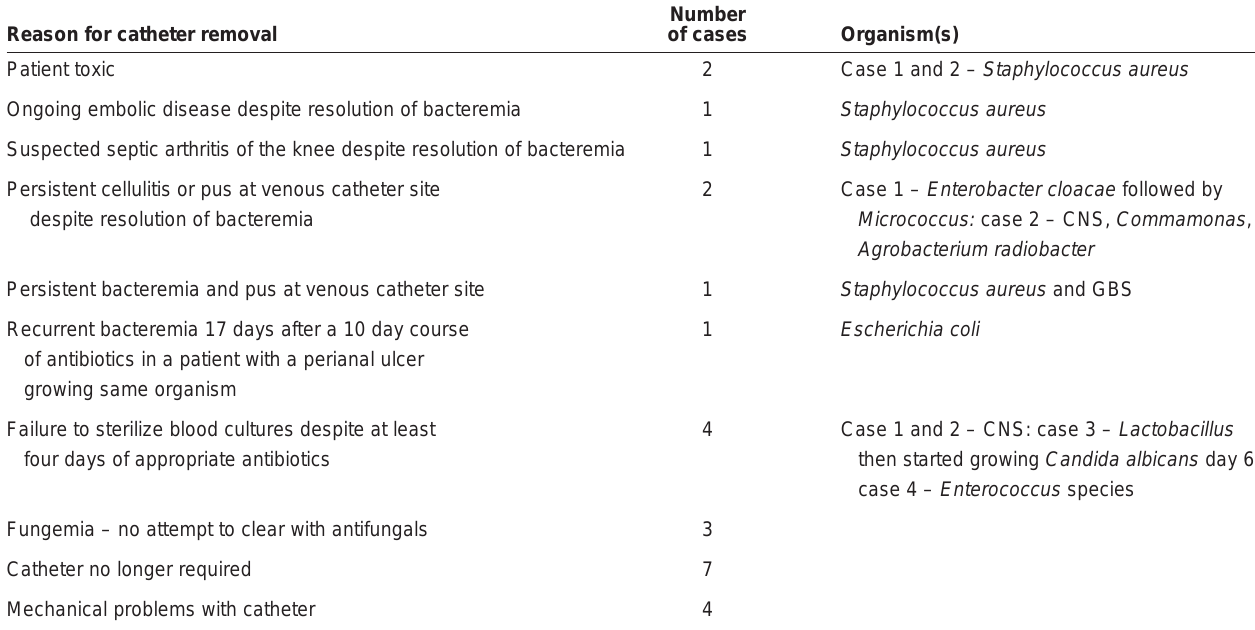
TABLE 2 Reasons for the removal of a tunnelled venous catheter in 26 of 119 episodes of positive blood cultures